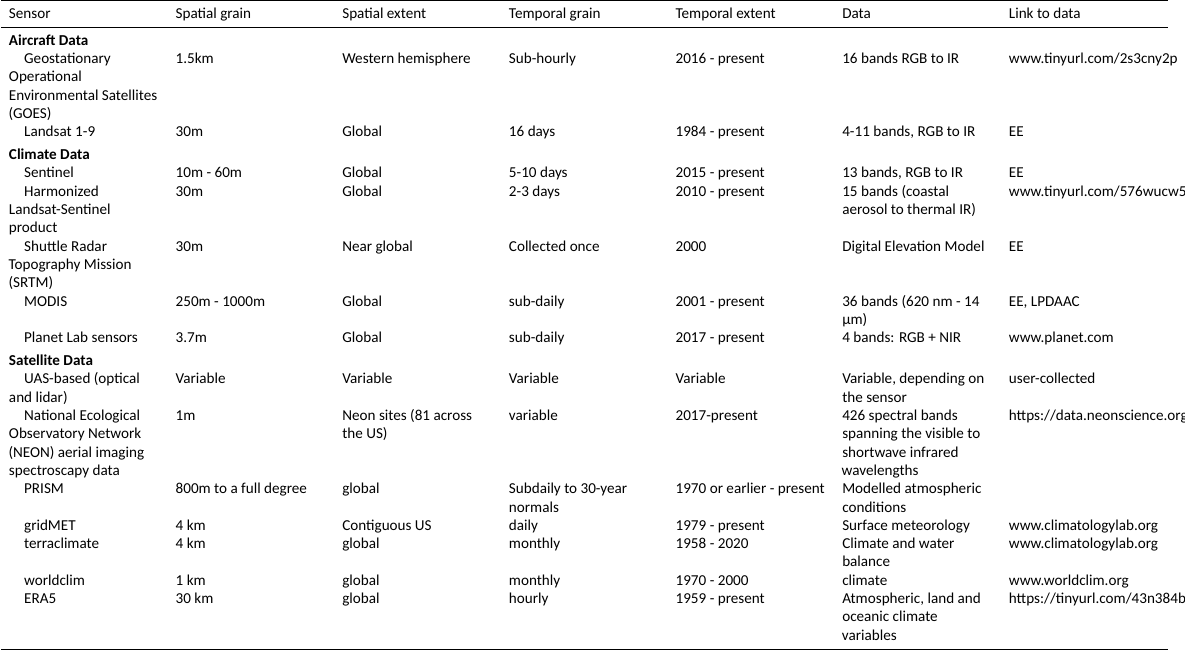
Table 1: Datasets mentioned in this